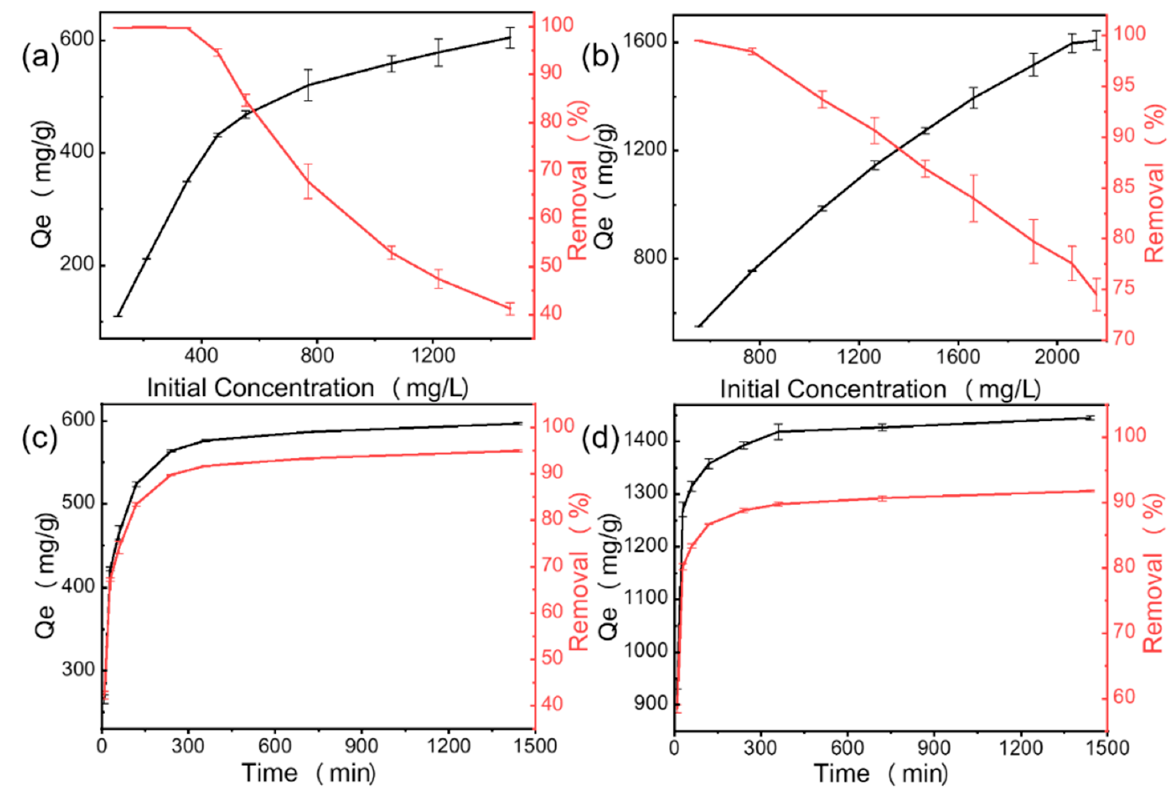
Figure 13. Effect of initial concentration and contact time on adsorption of MB with ( a , c ) CN and ( b , d ) MCS3 ‐ 1. ( b , d )